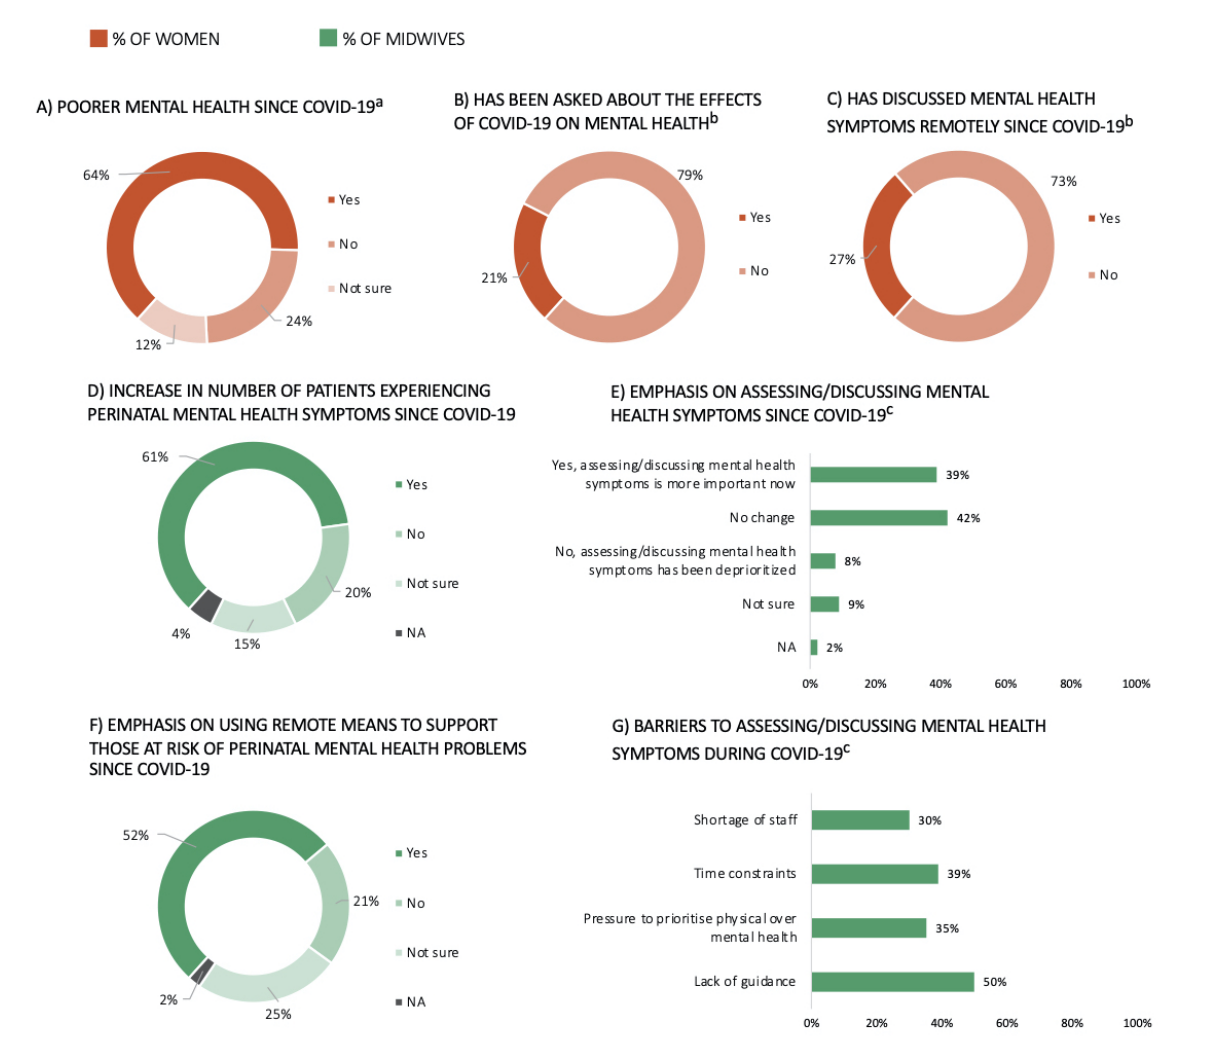
Figure 5. The effects of COVID-19 on women’s mental health and midwives’ mental health care provision, including the extent to which women had experienced poorer mental health since the outbreak (A), whether they had been asked about the effects of the pandemic on their mental health (B), and whether remote means (ie, telephone or video consultations) had been used to discuss their mental health throughout the pandemic (C). Regarding midwives’mental health care provision, this included the extent to which midwives had seen an increase in the number of patients experiencing mental health difficulties since COVID-19 (D), whether there had been an emphasis on assessing or discussing mental health symptoms throughout the pandemic (E), whether there had been an emphasis on using remote means (ie, telephone or video consultations) to support those at risk of perinatal mental health difficulties since COVID-19 (F), and the barriers to assessing or discussing mental health difficulties throughout the pandemic (G). a: Includes women who are pregnant or have given birth within the last 3 months (n=455); b: Includes women who are pregnant or have given birth within the last 3 months and have been in contact with a midwife since the lockdown (n=446); c: Percentages add to more than 100% as midwives could select multiple options. NA: not